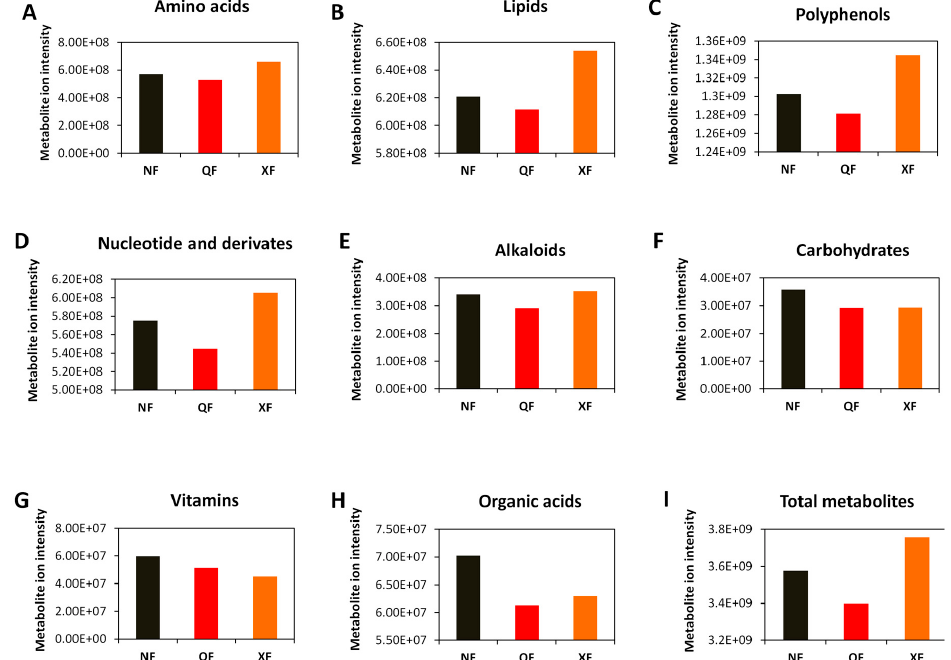
Figure 7. Comparison of the total ion intensity of various classes of metabolites between fruits from Ningxia (NF), Qinghai (QF) and Xinjiang (XF). ( A ) Amino acids, ( B ) lipids, ( C ) polyphenols, ( D ) nucleotides and derivatives, ( E ) alkaloids, ( F ) carbohydrates, ( G ) vitamins, ( H ) organic acids and ( I ) total metabolites. Bars represent the sum of ion intensity of all metabolites belonging to each class. By cross-comparing the different DAMs detected between samples from the three growing areas, only 13 metabolites were constitutively changed across of all the locations, indicating that these metabolites are highly sensitive to climatic fluctuations and may be used as biomarkers to rapidly identify the origins (planting areas) of wolfberry fruits in the market (Figure S1, Table 2). Table 2. List of metabolites showing constitutive differential accumulation between wolfberry fruits from three planting areas. Compounds